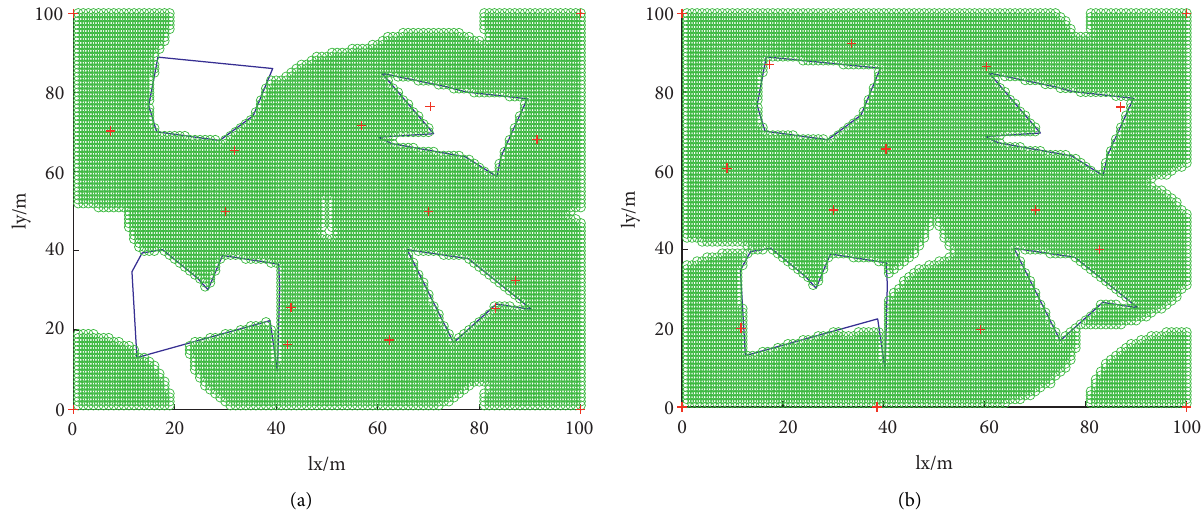
Figure 12: Network coverage of 10 nodes: (a) before optimization and (b) after